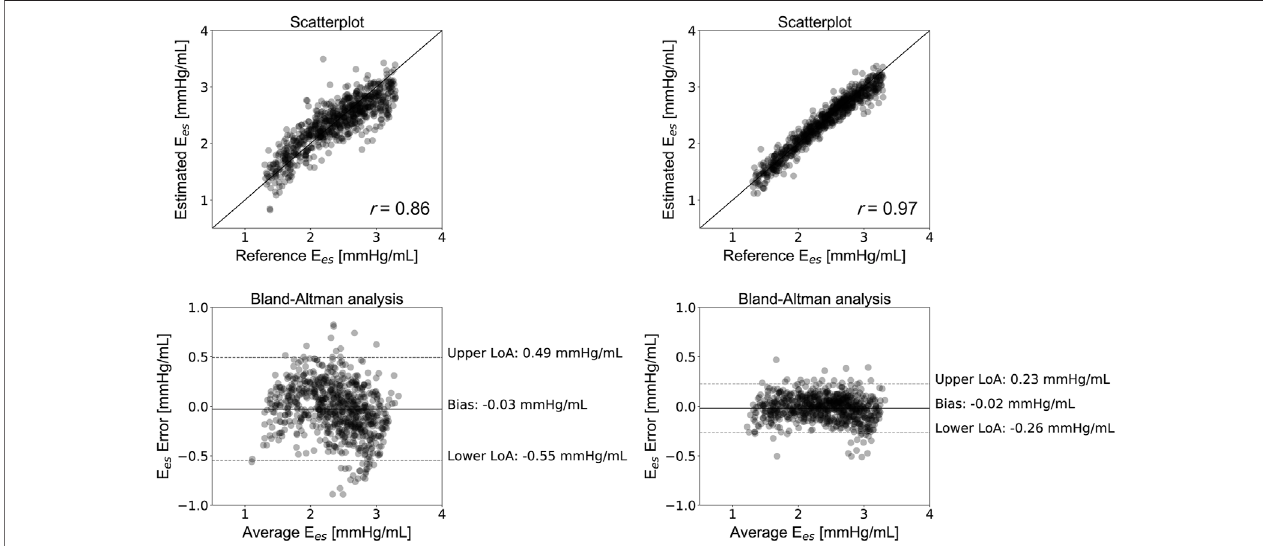
FIGURE 4 | Comparison between predicted and reference elastance data. Scatterplots and Bland – Altman plots between the predicted E es and the reference E es forCNN 1 (leftpanel) andCNN 2 (rightpanel). Thesolidlineofthescatterplotsrepresentsequality.InBland – Altmanplots,limitsofagreement(LoA),withinwhich95%of errors are expected to lie, are de fi ned by the two horizontal dashed lines.